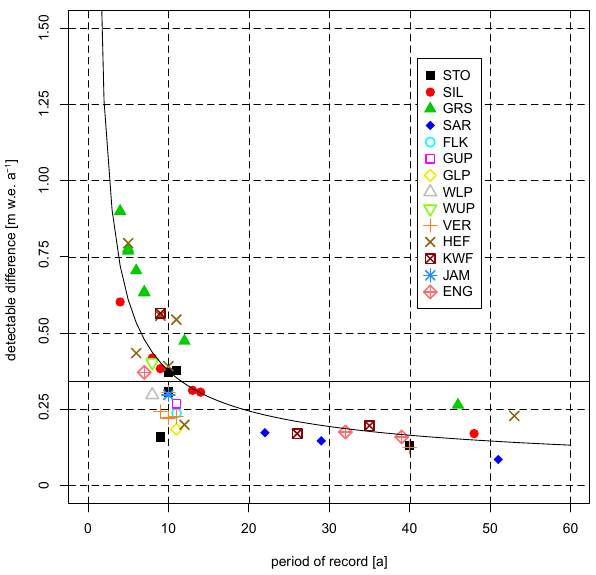
Fig. 5. Detectable difference as a function of the period of record. The horizontal line marks the mean random error of all glaciological balance series ( σ glac . a = 0.34mw.e.a − 1 ) . The curved line marks the minimum detectable annual difference (at 10% error risk) as a function of the number of years of the series as given by Eq. (25) using average values of random errors (i.e. glaciological and geode- tic measurements) for all data series. On average, ten years of data are required for the detectable difference to become lower than the annual random “noise” of the glaciological balance represented by σ glac . a